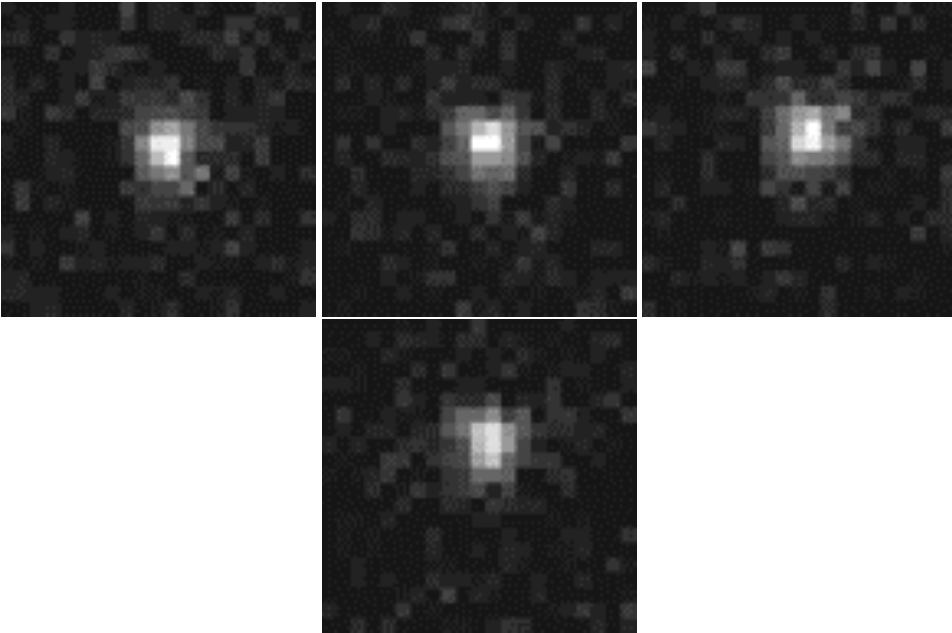
Figure 8. Four sequential segmented image frames from a synthetic motion